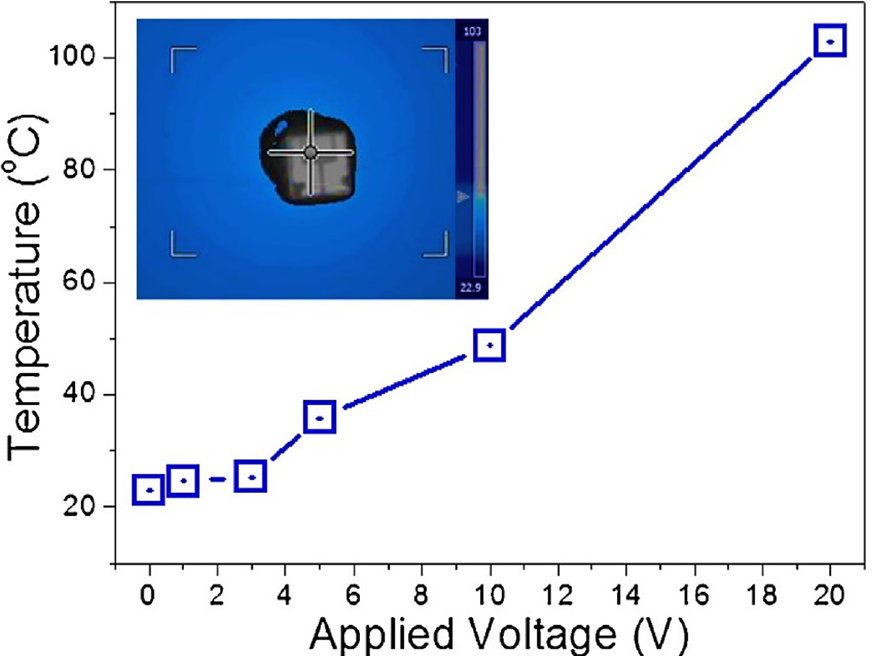
Figure 23. Variation in the generated temperature of the SnO 2 -ZnO C-S NW sensor with 80 nm-thick shell of ZnO as a function of the voltage applied (inset: thermograph of the sensor at 20 V). Reproduced from [115] with the permission of Elsevier.